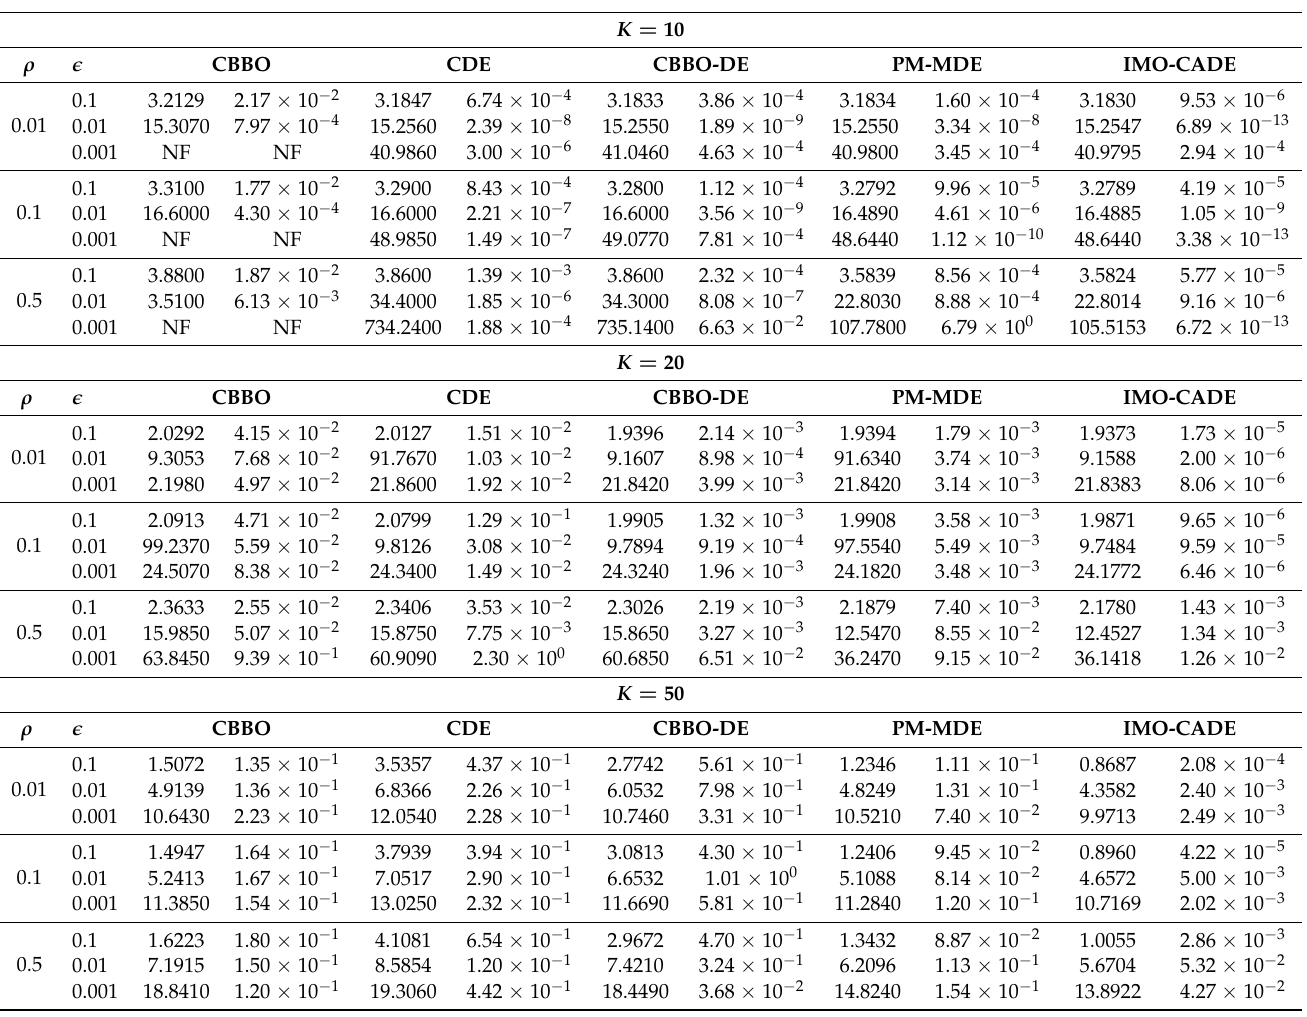
Table 5. Comparison with the reported results for the OPA under correlated observations.